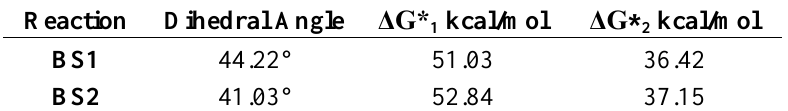
Table 3. Dihedral angles and Gibbs free energies of activation for BS1 and BS2 .